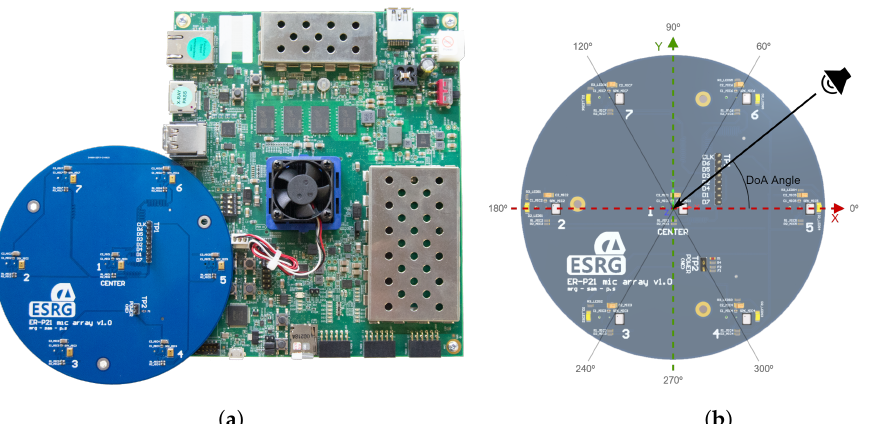
Figure 8. Sensor system prototype to localize and identify sound sources in an SAV and location of each microphone in the PCB to calculate the DoA. ( a ) Sensor system prototype. ( b ) Microphone’s location on a XY